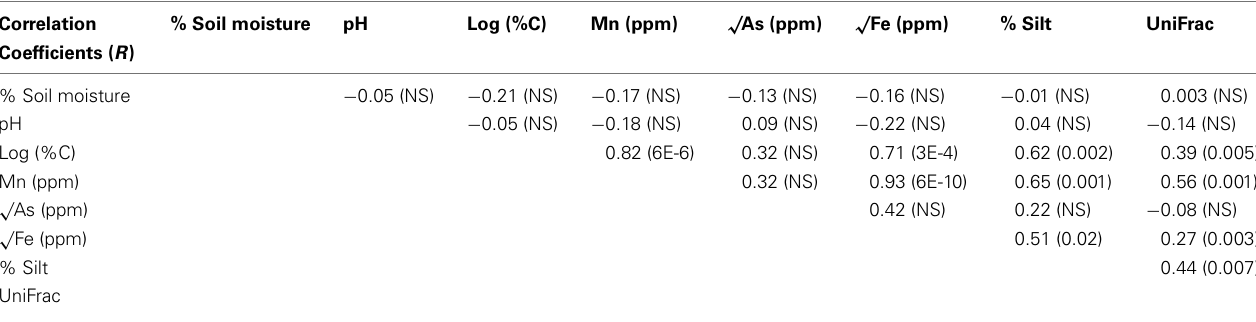
Table 1 |The correlation coefficients (R values) for the Pearson’s correlations that are presented in this table correspond to the pairwise correlations between individual environmental parameters or between environmental parameters and bacterial community beta diversity.